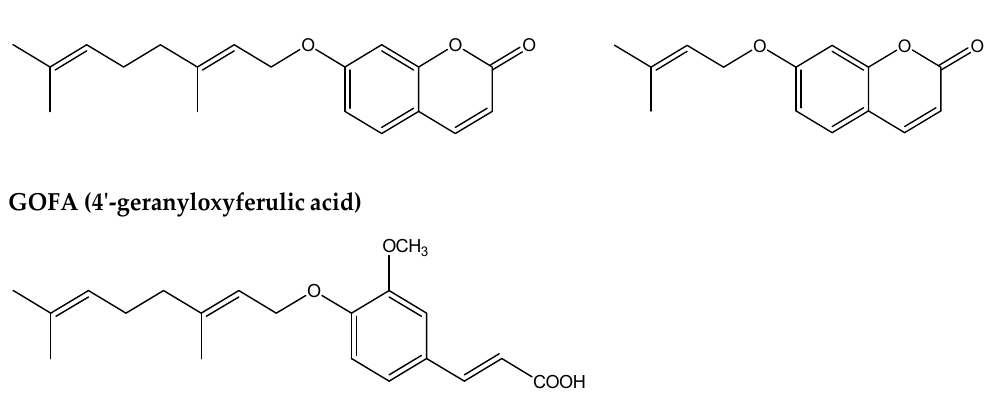
Figure 1. Structures of 7-geranyloxycoumarin (auraptene; AUR), 7-isopentenyloxycoumarin (7-IP), and 4 ′ -geranyloxyferulic acid (GOFA).